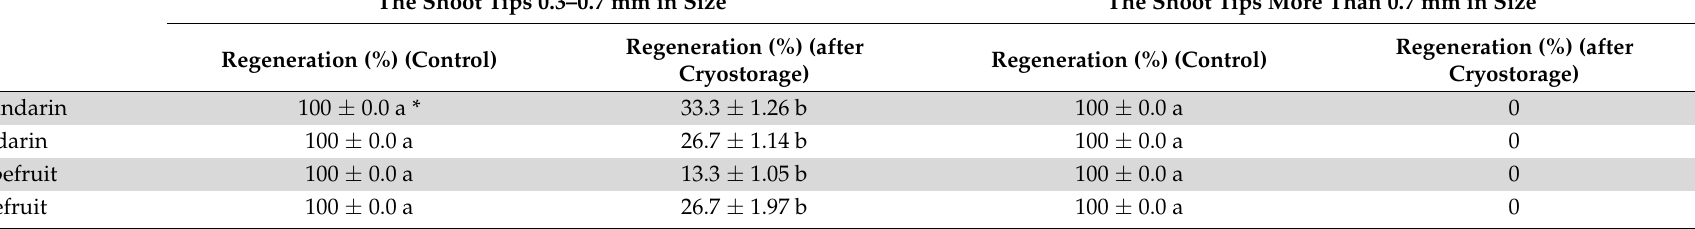
Table 3. The regeneration of two differently sized shoot tips of four different Citrus spp. Cultivars. The shoot tips treated with PVS2 for 45 min were incubated in regeneration medium for the first 24 h, and then they transferred to WPM medium supplemented with 1 mg.L − 1 BAP, 10 mg.L − 1 activated charcoal, and 1 mg.L − 1 H 3 BO 3 medium for four weeks under standard culture conditions.